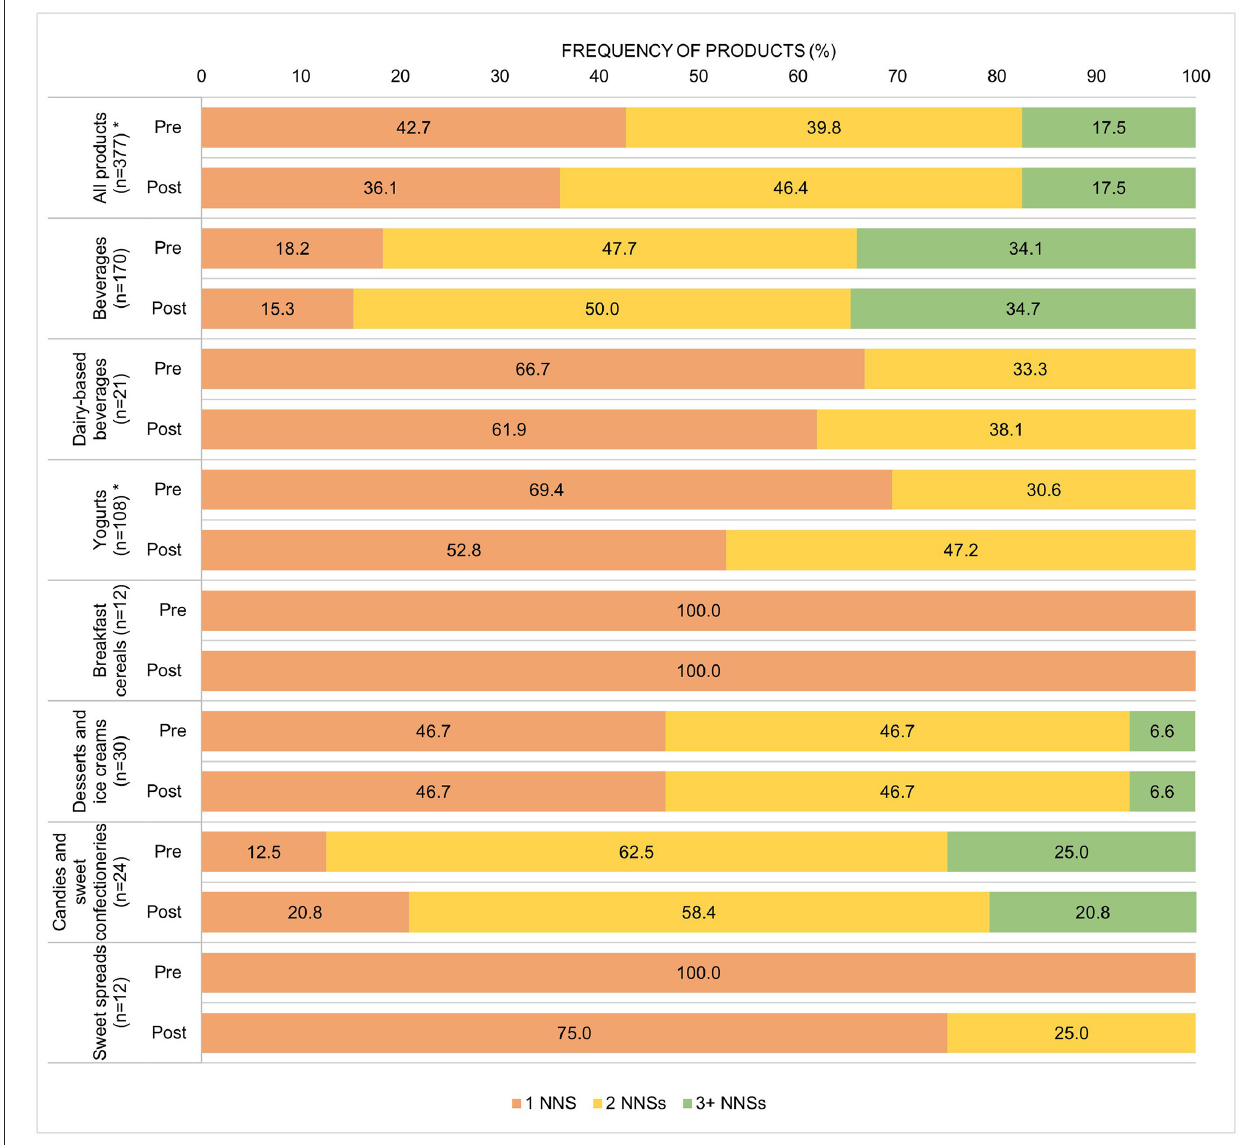
FIGURE 1 | Number of different NNSs used in the pre- and post-implementation periods by food or beverage group. * p value < 0.001 in the Wilcoxon signed-rank